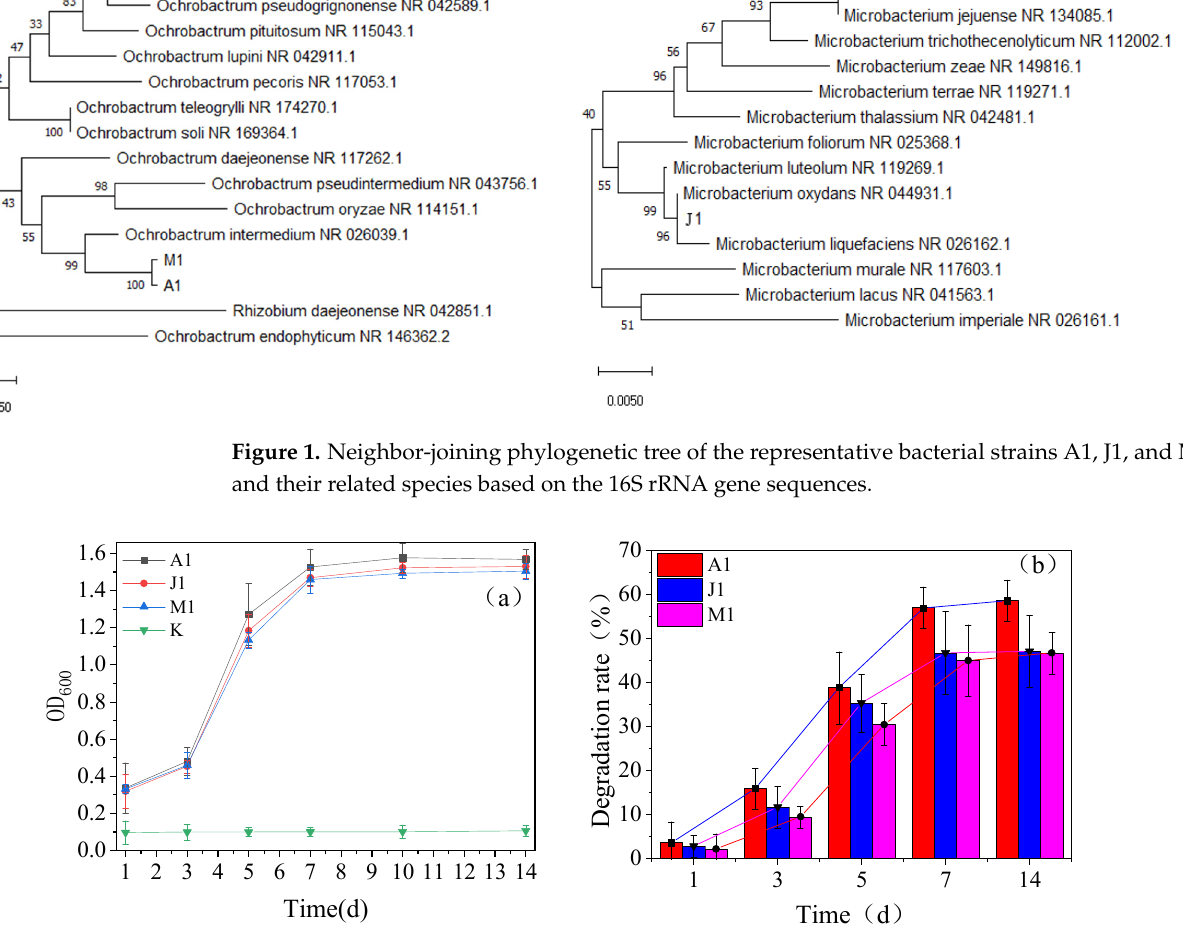
Figure 1. Neighbor-joining phylogenetic tree of the representative bacterial strains A1, J1, and M1, and their related species based on the 16S rRNA gene sequences.